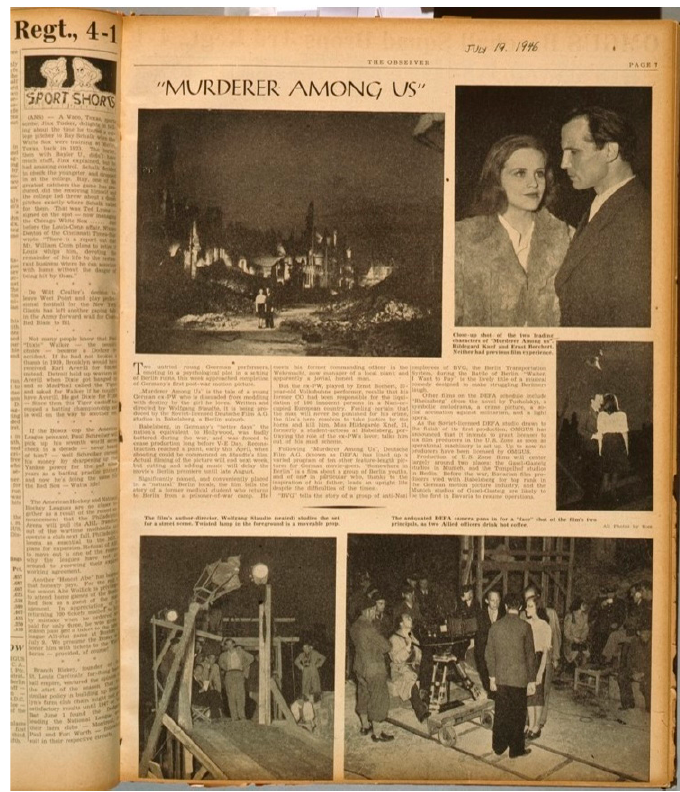
Figure 13. “Murderer Among Us.” OMGUS Observer on 19 July 1946. Photograph. © Henry Ries. Deutsches Historisches Museum.